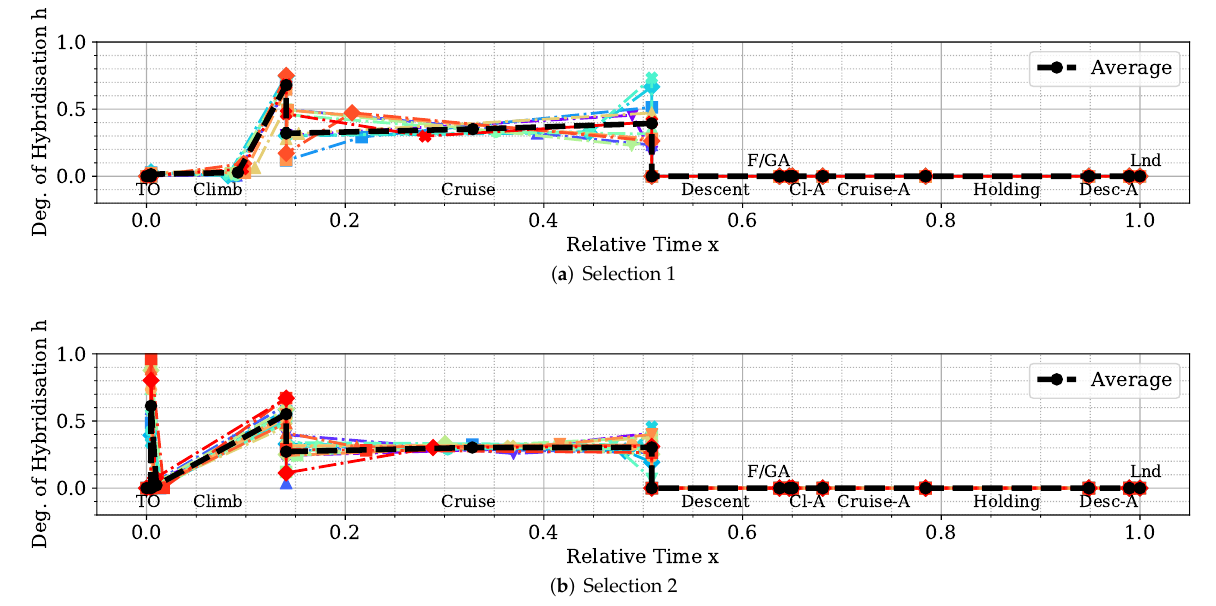
Figure 19. Visualisation of Experiment 10 energy management strategies. Three possible general shapes for the energy management strategy are